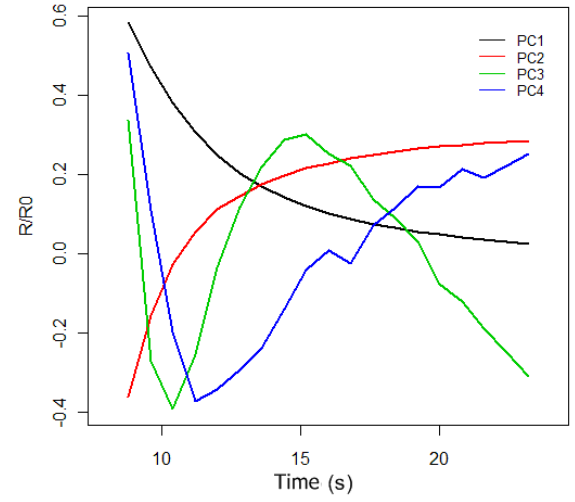
Figure 6. First four principal components of the